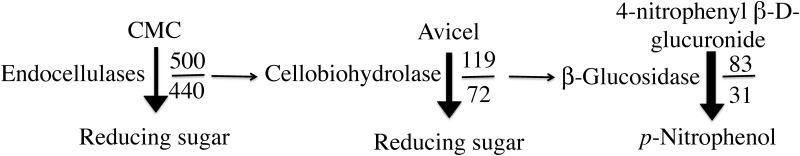
Population F1 showed higher activity (in U/L culture) for all three of the activities needed for cellulose deconstruction as compared to the ancestor (compare top versus bottom numbers).The three types of activities were measured using three different substrates: carboxymethylcellulose (CMC) for endocellulase activity, crystalline cellulose (Avicel) for cellobiohydrolase activity and 4-nitrophenyl β-D-glucopyranoside for β-glucosidase activity. The endocellulase activity increased 1.2-fold in population F1 as compared to the ancestor, the cellobiohydrolase activity increased 2.1-fold and the β-glucosidase activity increased 2.7-fold.